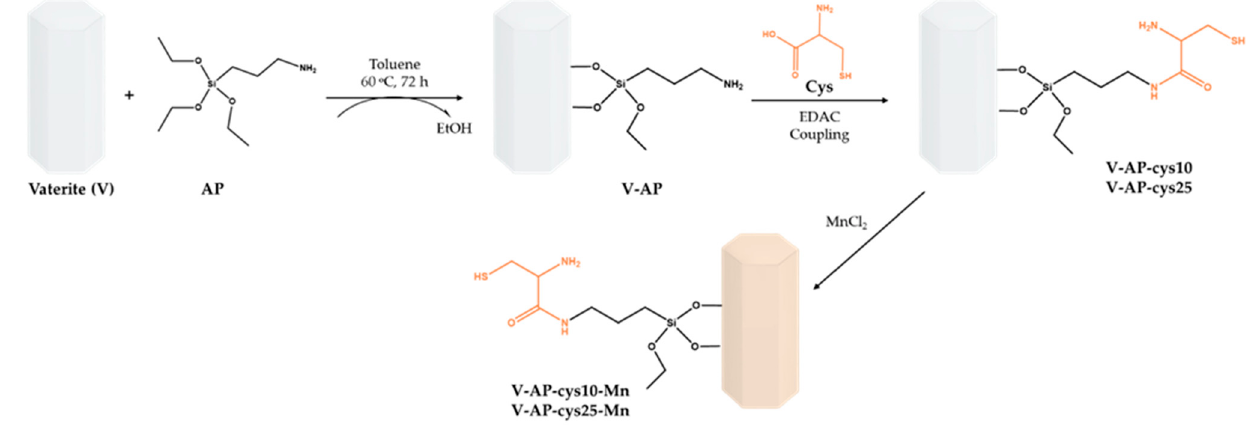
Scheme 1. General scheme of the synthesis of vaterite materials.